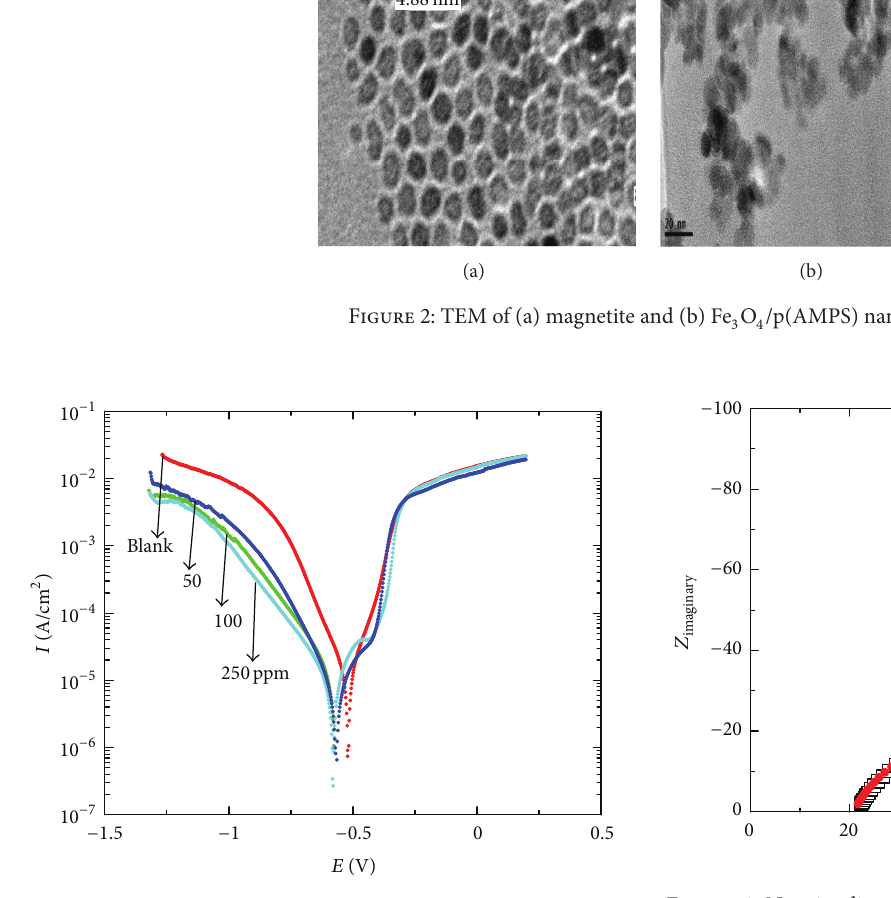
Figure 3: Polarization curves for carbon steel in 1M HCl solution containing different inhibitor concentrations.